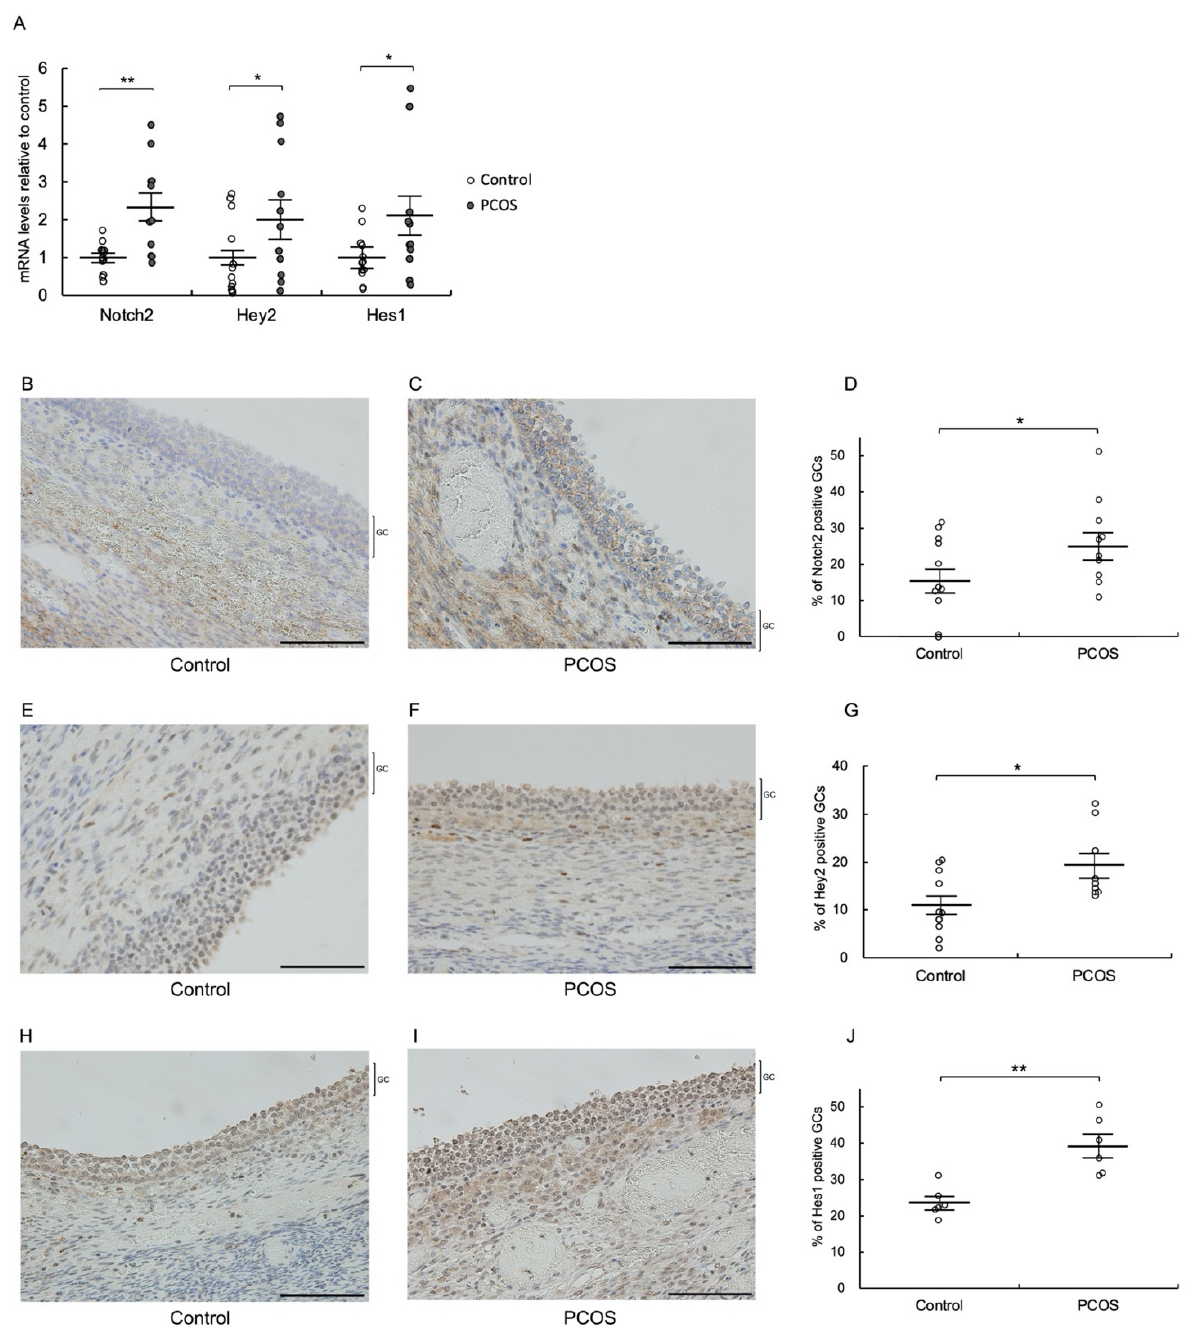
Figure 1. Notch2, Hey2, and Hes1 are upregulated in granulosa cells of PCOS patients. ( A ) The expression levels of Notch2, Hey2, and Hes1 mRNAs in GLCs from control (n = 12) and PCOS (n = 11) patients were measured by real-time PCR and normalized to that of GAPDH. ( B – J ) Immunohistochemical analysis was performed on antral follicles of ovaries from control (n = 3) and PCOS (n = 4) patients. Cross-sections of ovaries were stained with an ( B – D ) anti-Notch2, ( E – G ) anti-Hey2, or ( H – J ) anti-Hes1 antibody and counterstained with hematoxylin. ( D , G , J ) Quantitative analysis of immunohistochemical staining. Values represent means ± SEM, relative to the mean control value. The scale bars indicate 100 µm. * p < 0.05 and ** p < 0.01 compared with control. GC, granulosa cell layer; GCs granulosa cells.